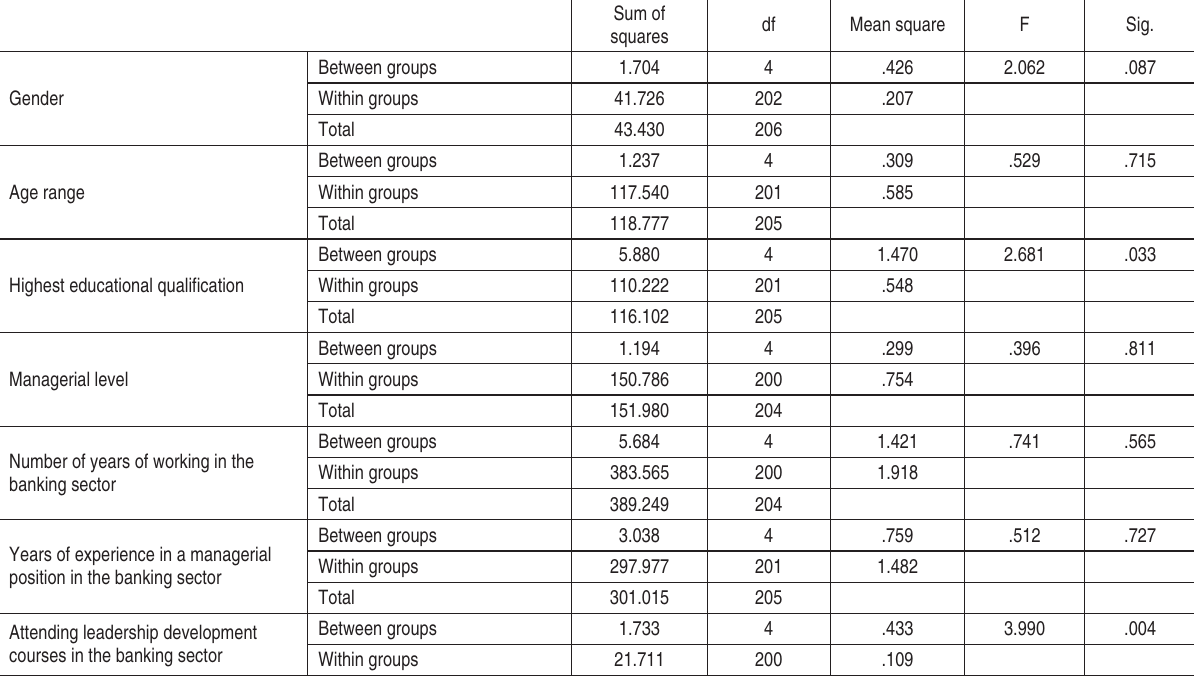
Table 4 ANOVA analysis - perceived awareness of emotional